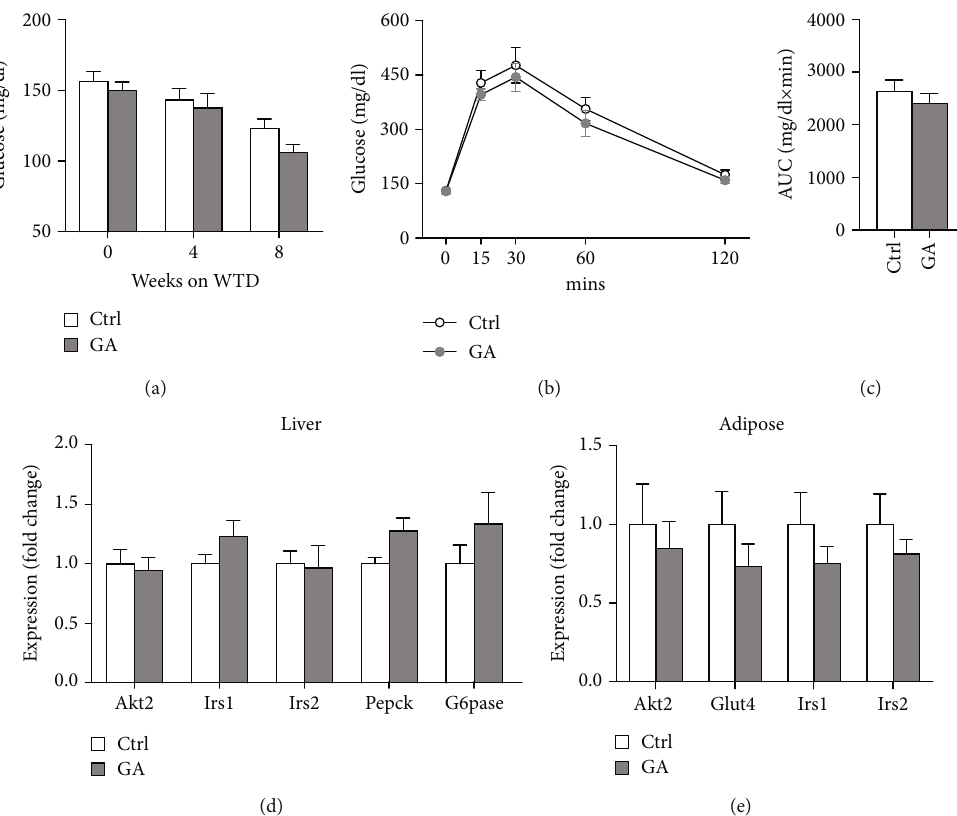
Figure 4: E ff ect of low-dose GA administration on diet-induced insulin resistance in the Apoe KO mice. (a) Plasma glucose levels during WTD feeding. (b, c) Glucose tolerance test after 6 weeks on WTD feeding (b) and quantitation of area under curve (c). (d, e) Quantitative real-time PCR analysis of insulin resistance-related gene expression in the liver (d) and Epi WAT (e). n = 6 -8 per